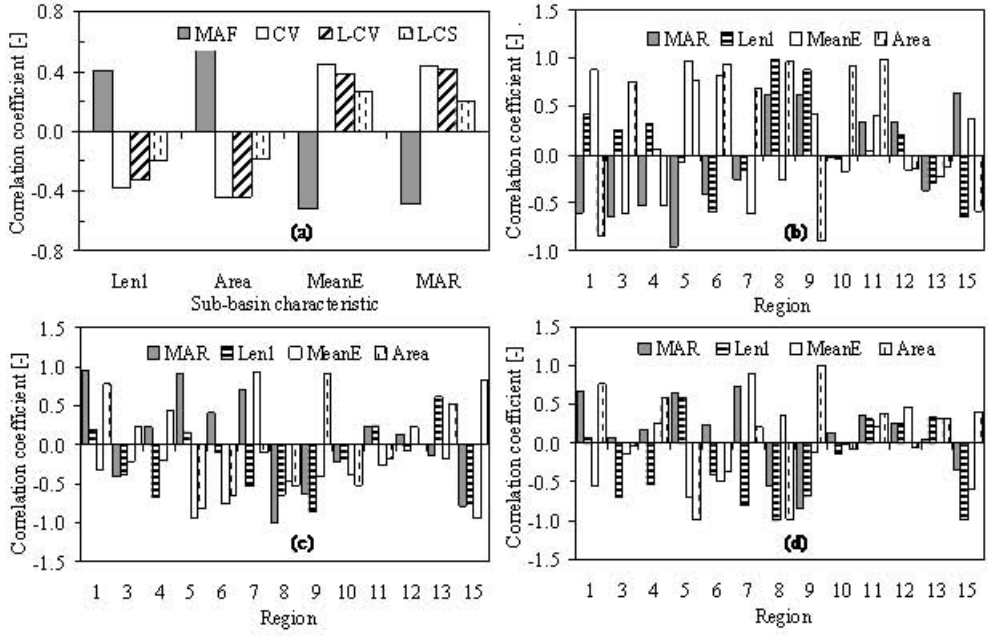
Fig. 8. Correlation coefficients between catchment characteristics and flood properties: (a) for the entire dataset of the basin (b) MAF values per region (c) CV values per region (d) L -CS values per region. MeanE: catchment mean elevation (H); Len1: catchment average stream reach length ( L